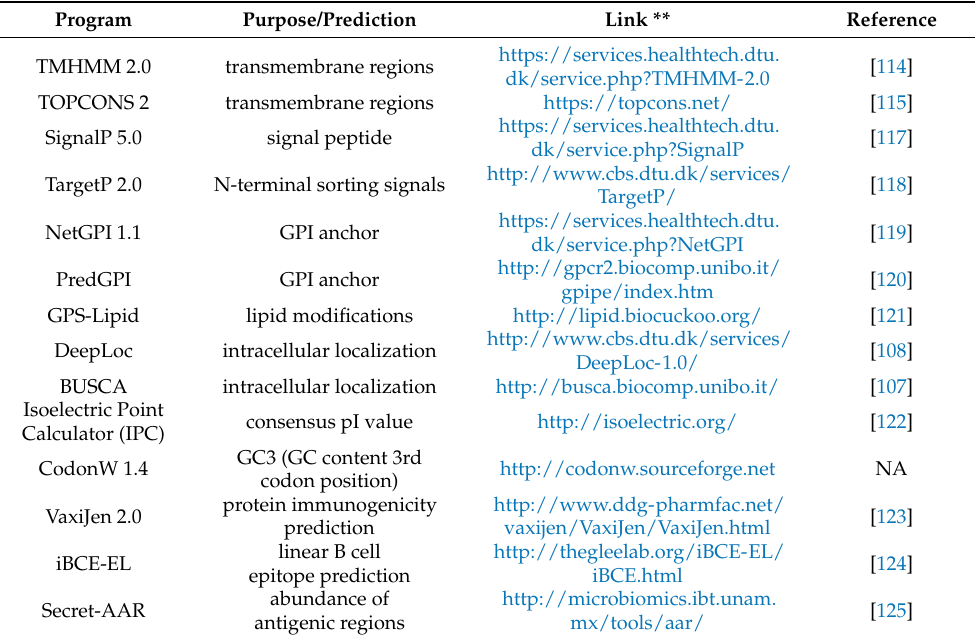
Table 4. An overview of the characteristics and purpose of different prediction programs used in this study